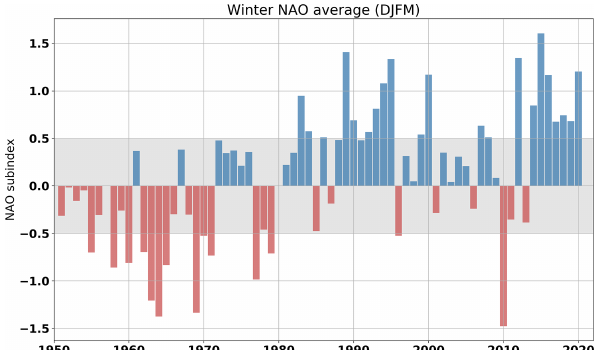
Figure 2. Winter North Atlantic Oscillation (NAO) index averaged over December to March. Here positive anomalies, generally in- dicative of colder conditions, are coloured in blue. The shaded area corresponds to ± 0 . 5SD, indicating normal conditions. This time series is one component of the NL climate